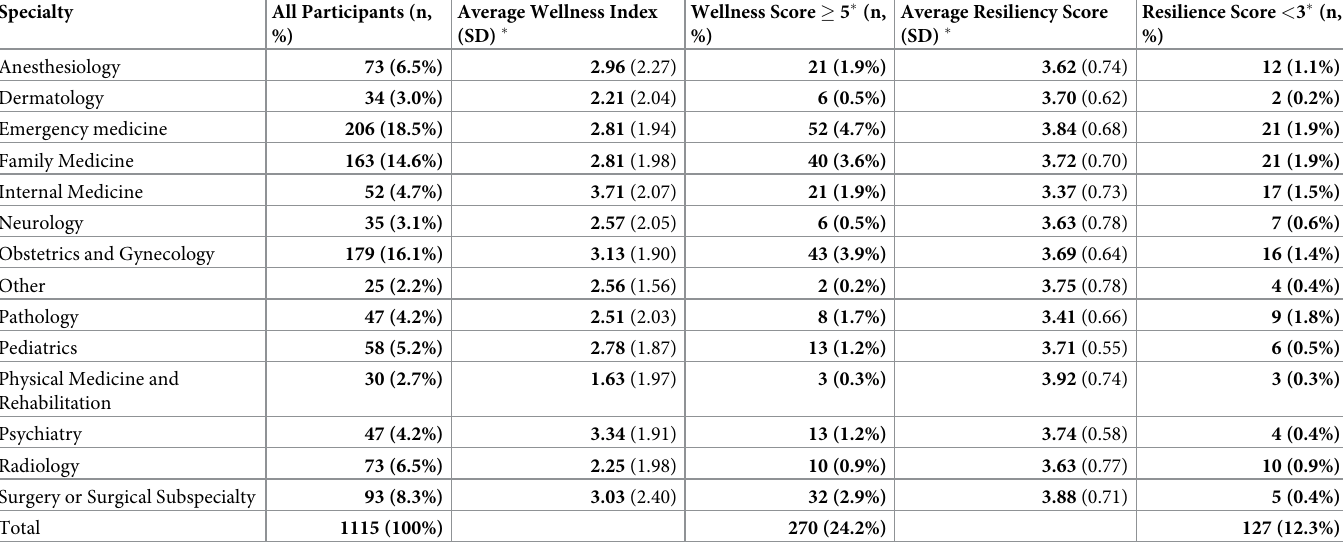
Table 2. The distribution of survey participants relative to specialty correlated with wellness and resilience scores.